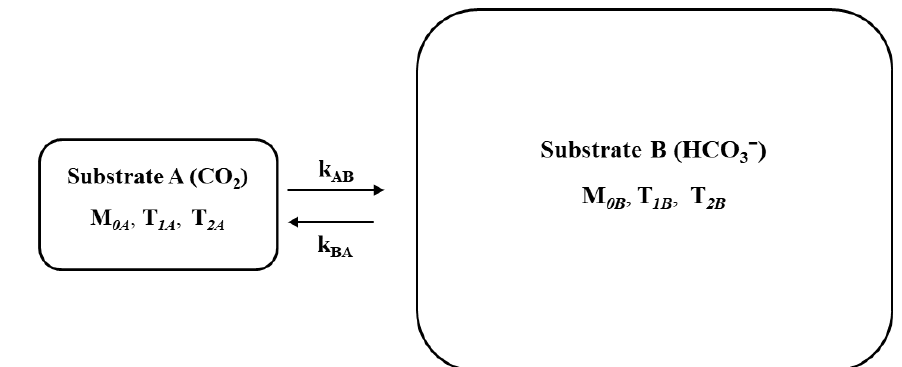
Figure 1. The two-site exchange diagram for CO 2 ↔ HCO 3 − catalyzed by carbonic anhydrase. M 0 A and M 0 B denote the magnetization of CO 2 and HCO 3 − at thermal equilibrium. T 1 A , T 1 B and T 2 A , T 2 B are their respective longitudinal and transverse relaxation times without any chemical exchange. k AB and k BA represent the pseudo-first-order rate constants of the unidirectional CO 2 → HCO 3 − hydration and HCO 3 − → CO 2 dehydration reactions, respectively.